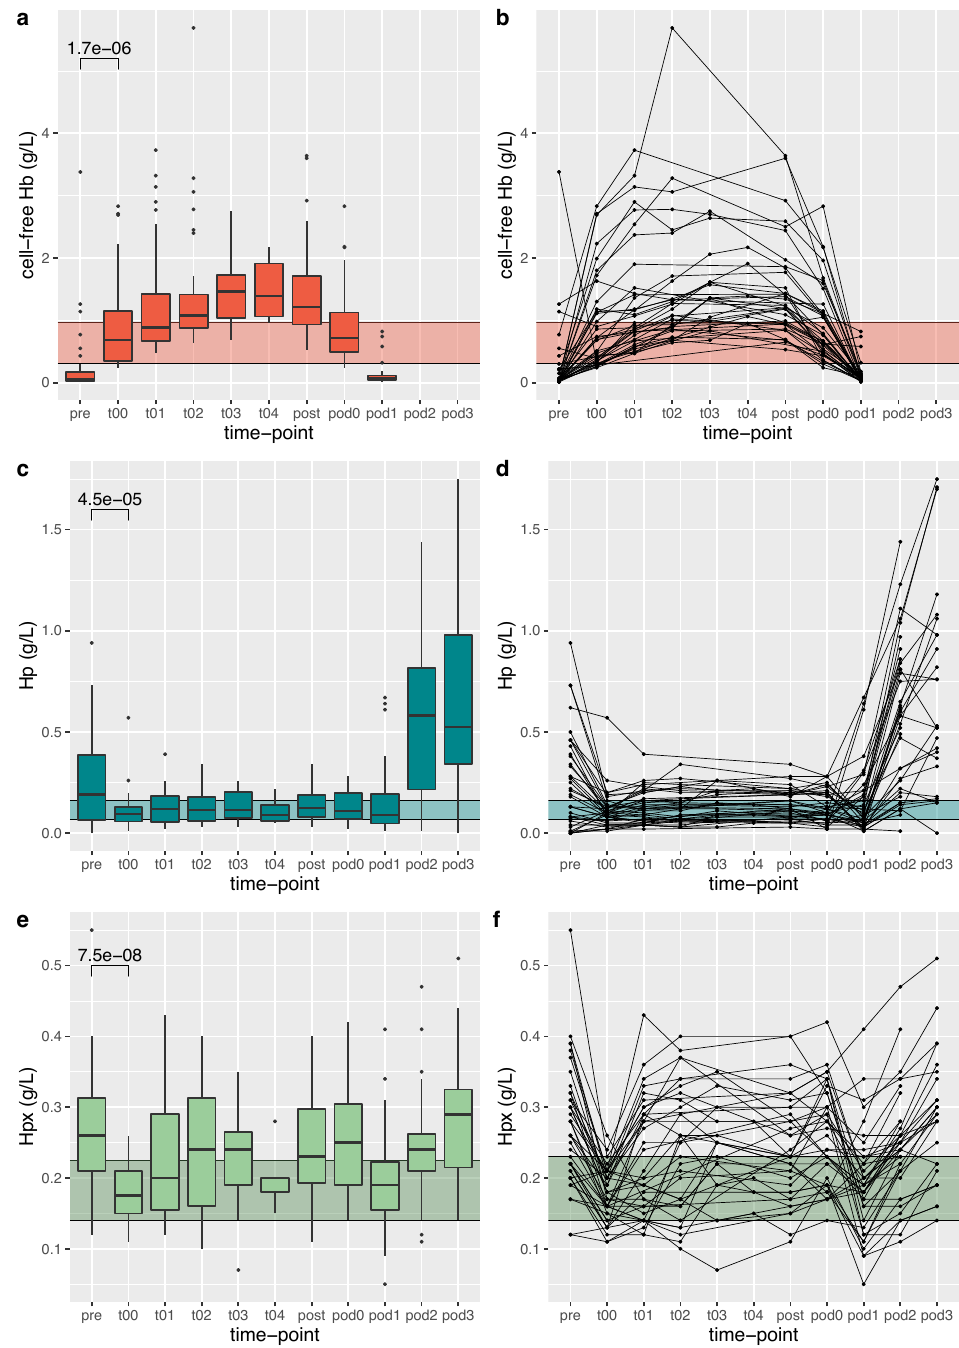
Figure 2. Aggregated ( a , c , e ) and individual ( b , d , f ) data on cell-free hemoglobin ( a , b ), haptoglobin ( c , d ) and hemopexin ( e , f ) concentrations during the study period. The shaded area represents the interquartile range of concentrations of respective protein in prime solution. Hb = hemoglobin, Hp = haptoglobin, Hpx = hemopexin, pre = preoperative sampling, t00–t04 = hourly sampling during CPB circulation, post = sampling after bypass separation, pod0 = admission to pediatric intensive care unit after surgery, pod1–3 = postoperative day